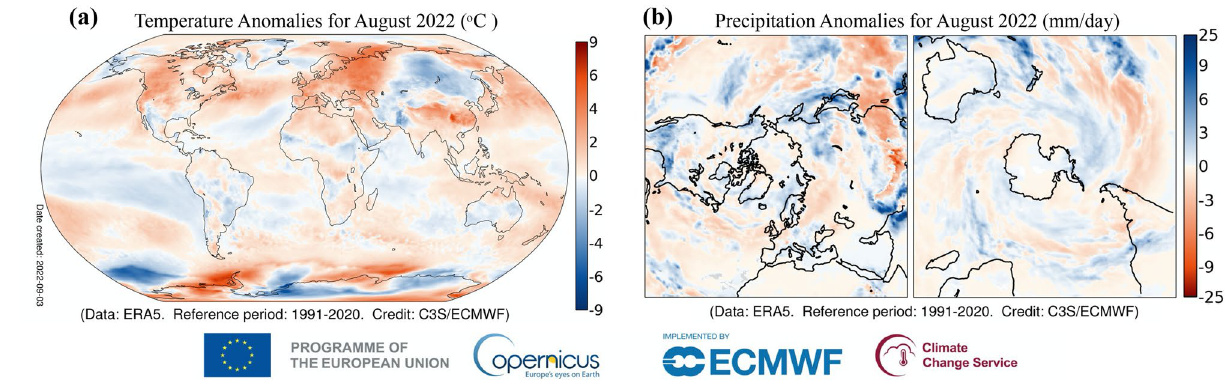
Fig. 1 a Temperature and b Precipitation anomalies for August 2022 with respect to the reference period of 1991−2020. Sources Coper- nicus Climate Change Service/ECMWF at https:// clima te. coper nicus.